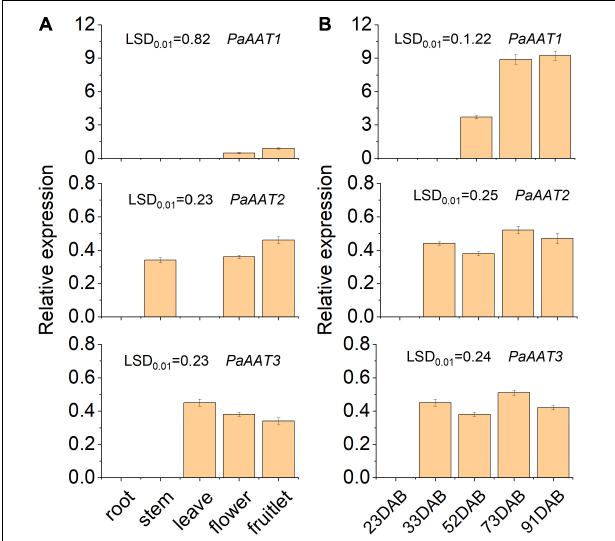
FIGURE 4 | Expression of three AATs in different tissues during apricot fruit ripening. (A) Expression of three AATs in different tissues. (B) Expression of three AATs in fruit during ripening. Error bars indicate the standard error from three biological replicates. LSD, least significant difference ( p <